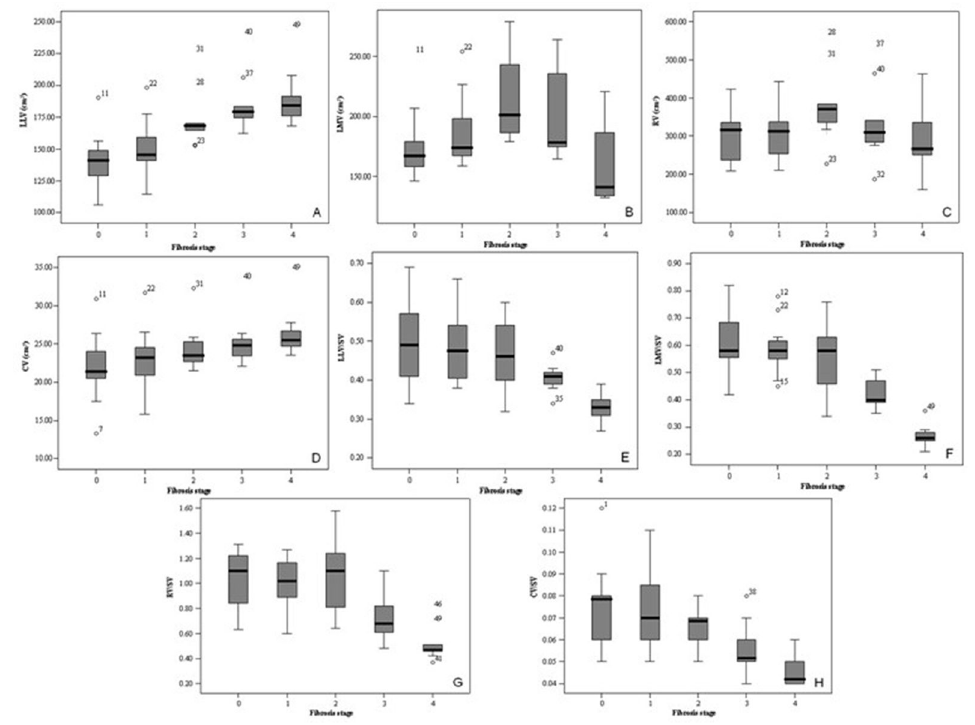
Figure 3. Box plots of liver lobe volume parameters for each fibrosis stage. The figure shows distributions of left lateral liver lobe volume (LLV, A), left medial liver lobe volume (LMV, B), right liver lobe volume (RV, C), and caudate lobe volume (CV, D) as well as the ratios of LLV to SV (LLV/SV, E), LMV to SV (LMV/SV, F), RV to SV (RV/SV, G), and CV to SV (CV/SV, H) stratified by fibrosis stages.